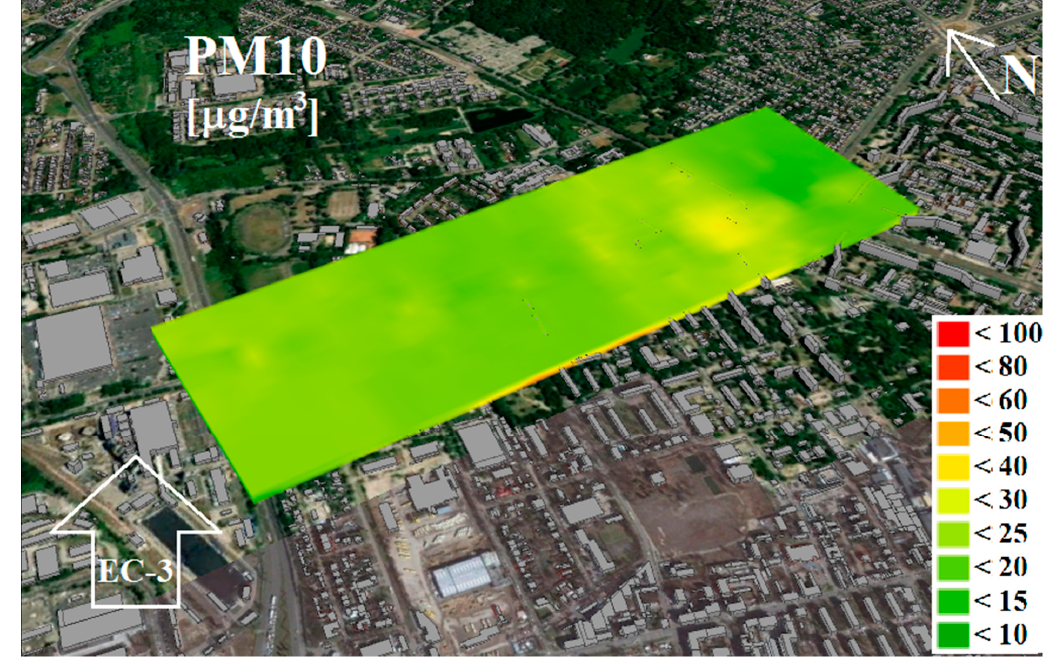
Figure 13. Spatial distribution of PM 10 concentration for a selected location in the vicinity of EC-3.